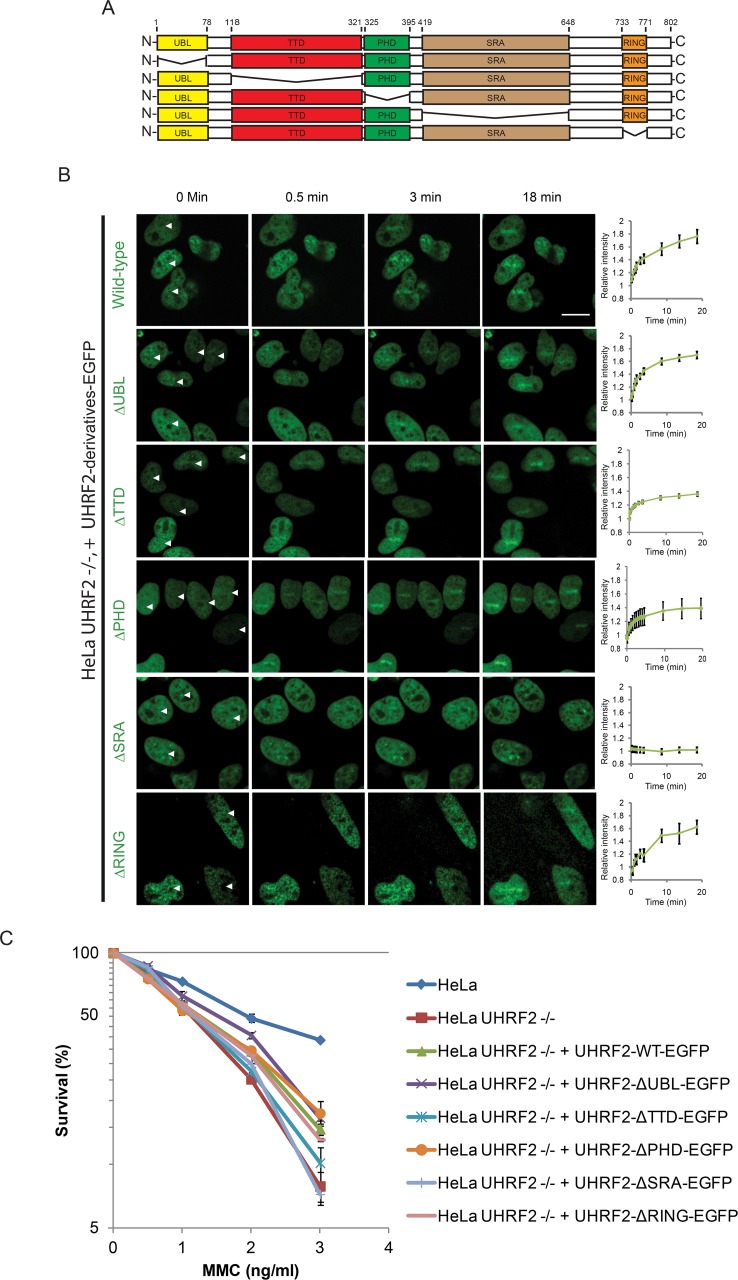
The SRA domain of UHRF2 is required for its recruitment to ICLs.A) Schematic representation of UHRF2 indicating positions of domains and deletions. B) Live-cell imaging of HeLa UHRF2 -/- cells (CRIPR/Cas9-mediated knockout) complemented with EGFP-tagged UHRF2 containing deletions as indicated in (A). Cells were pre-treated with TMP and micro irradiated at the sites indicated with white arrows. Scale bar indicates 10μm. Charts indicate quantification of relative intensity of signal at the irradiated sites. The p-values between EGFP-UHRF2 and EGFP-UHRF2-ΔTTD, EGFP-UHRF2-ΔPHD and EGFP-UHRF2-ΔSRA at the 20 min time-point are 0.001, 0.001, and 0.0000008, respectively. Error bars show SEM n = 8/treatment. C) Clonogenic survival assay of HeLa UHRF2 -/- cells complemented with the UHRF2 domain deletion mutants indicated in (A). Experiment was repeated 2 times and with p-values for EGFP-UHRF2-ΔSRA and EGFP-UHRF2-ΔTTD compared to EGFP-UHRF2 of 0.03 and 0.175, respectively. Error bars show SEM.